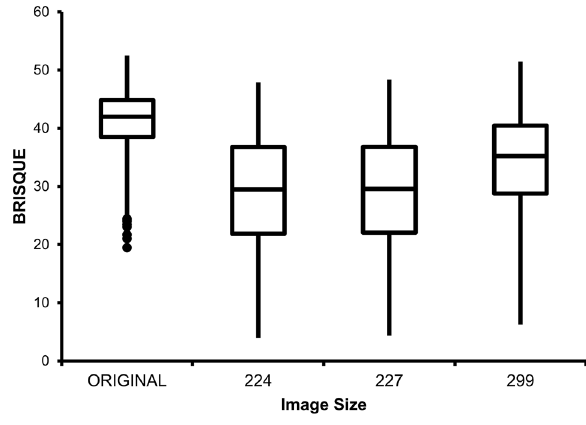
Figure 3. BRISQUE score according to facial US image size change. 224: 224 × 224 × 3, 227: 227 × 227 × 3, 229: 229 × 229 ×